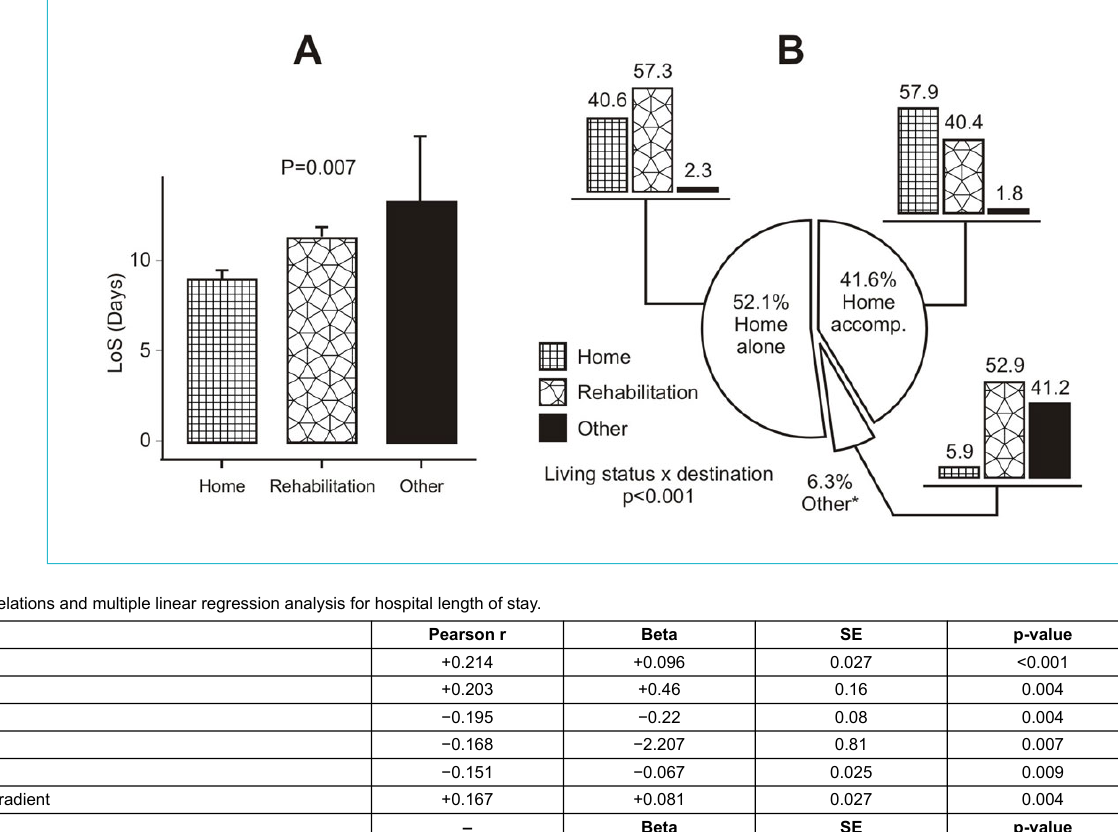
Figure 3: Length of hospital stay and patients’ destination after the intervention (panel A). Patient destination according to the baseline living status after the TAVI (panel B).Los = length of stay; TAVI = transcatheter aortic valve replacement* Other clinic/hospital